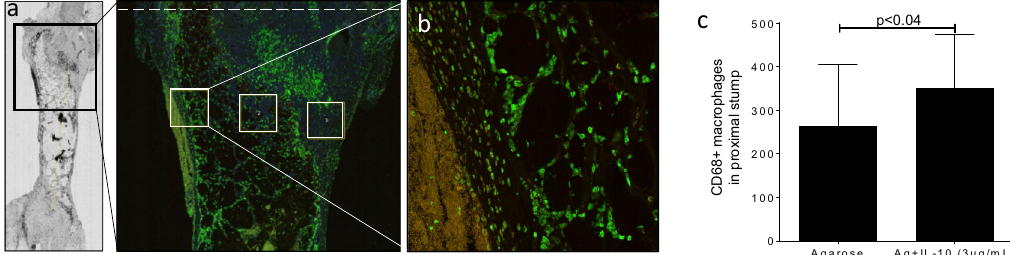
Fig. 9 Transient immunomodulation in rats promotes macrophage recruitment. a Representative regenerative bridge after immunohistochemistry staining with CD68 + macrophages (green) 10 days after placement of a 10 mm conduit after sciatic transection. Counts obtained from three 500 µm × 500 µm regions of interest (ROI, white rectangles) per section (three sections/animal) per group. ROI placed on the periphery of the proximal stump of the regenerative bridge and centrally (white dashed line indicates the proximal stump). b Selected region of interest. Total number of CD68 + macrophages is increased ( c ) in the presence of exogenous IL10 ( P < 0.04, t test).